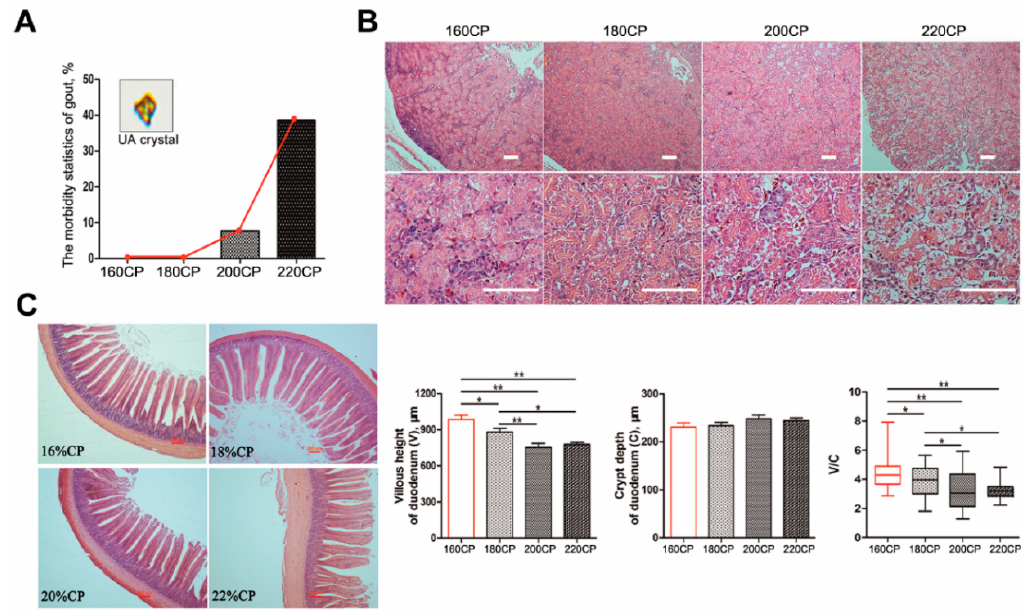
Figure 1. Evaluation of changes in renal injury and intestinal morphology in goslings with different protein diets. ( A ) The morbidity of gout in goslings with different protein diets; ( B ) morphological observation of the kidney by HE stain (Bar = 100 μ m). ( C ) Morphological observation and of the intestinal villus among groups (HE staining, Bar = 200 μ m); ( D ) the comparisons of villus height, crypt depth, and their ratio in duodenum. Asterisks represent differences between groups being significant (* P < 0.05, ** P < 0.01).